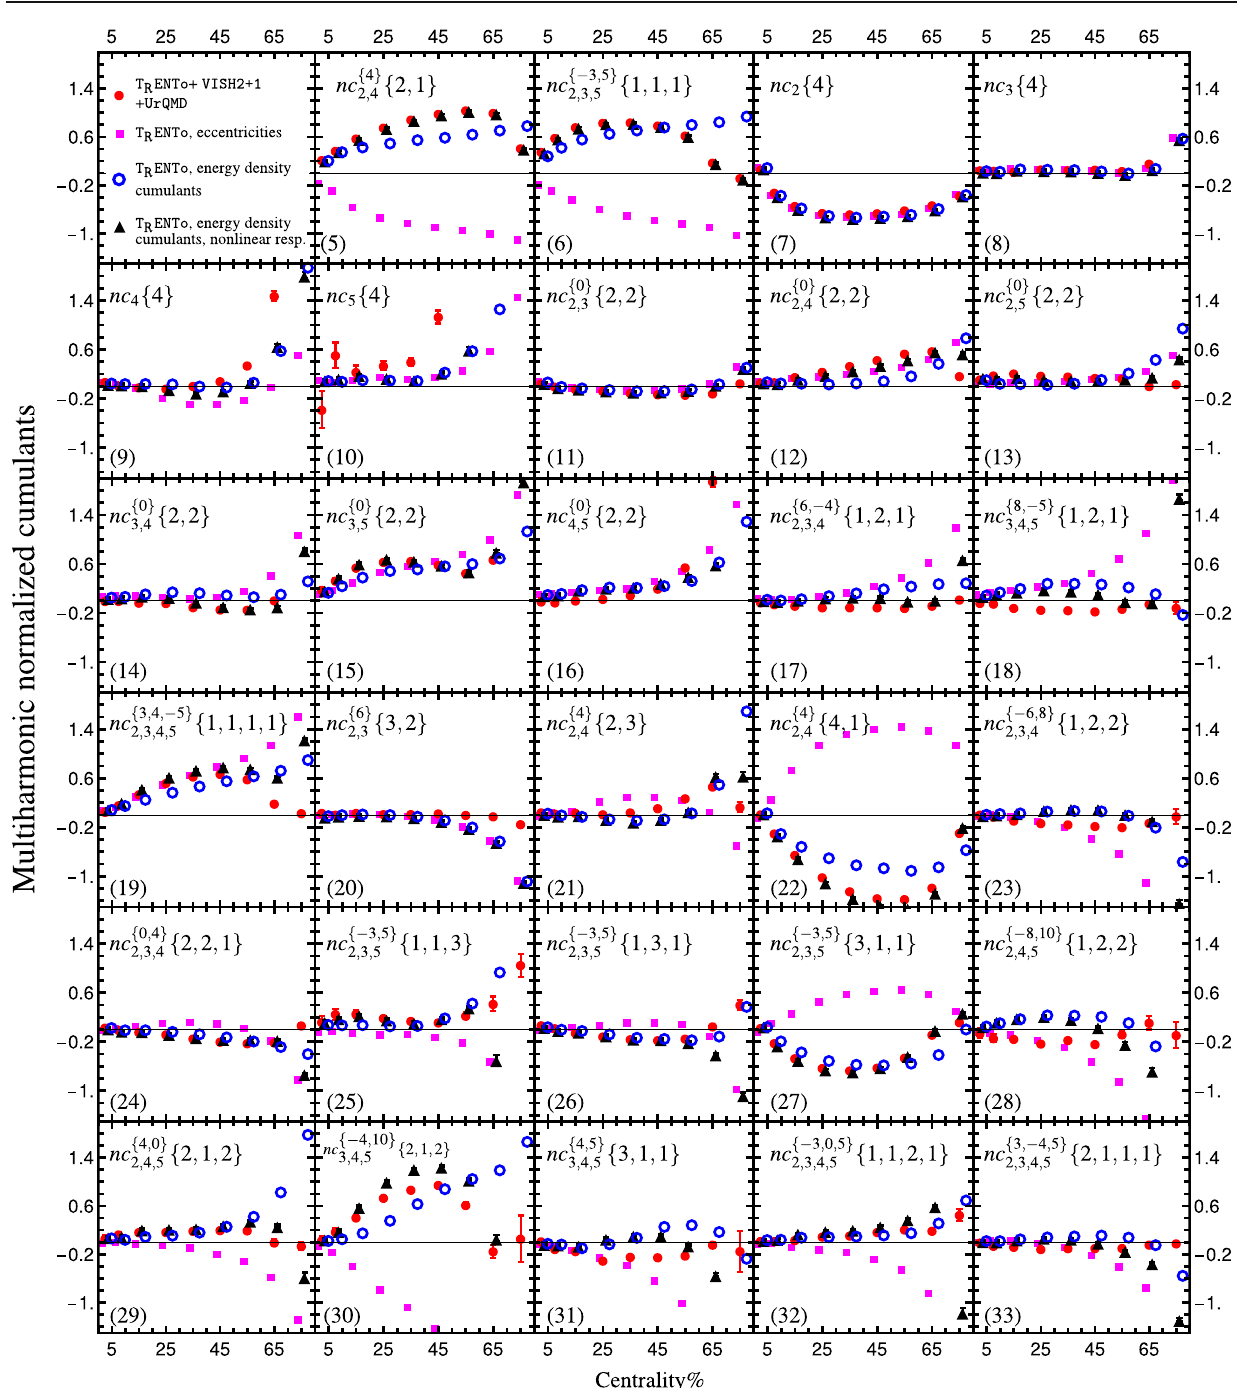
Fig. 1 All 2 , 3 , 4 , 5-order normalized cumulants for harmonics n = 2 , 3 , 4 , 5. Magenta squares and open blue circles are eccentricity and energy density cumulant fluctuations from T R ENTo initial state model, red filled circles are flow fluctuations after hydrodynamic evolution